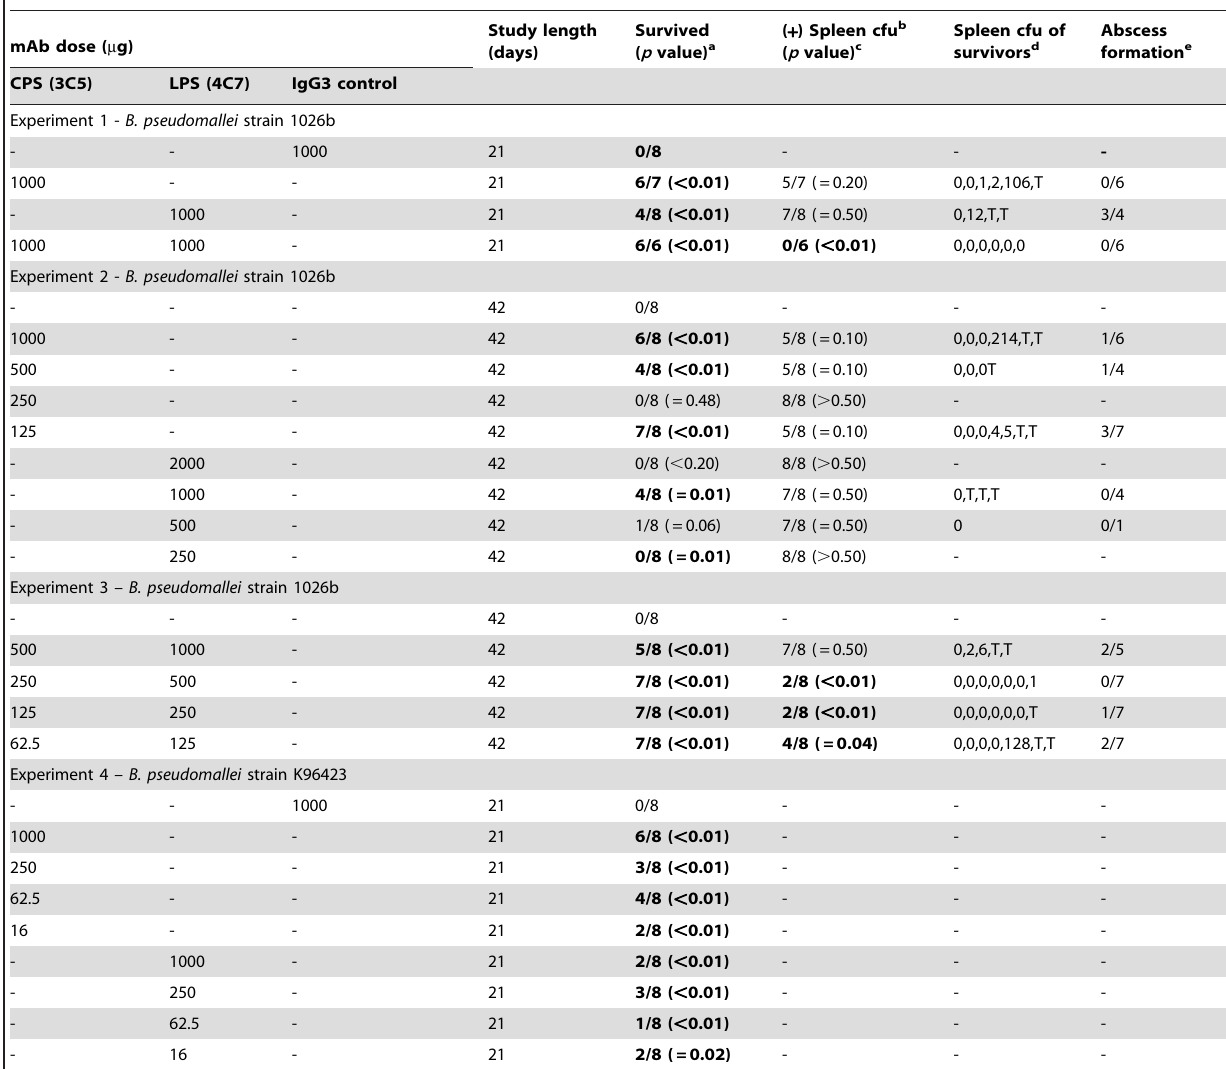
Table 1. Survival and gross pathology of mice passively treated with